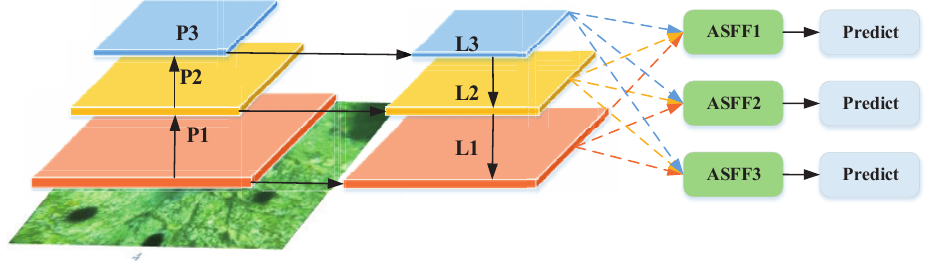
Figure 2. Structure diagram of